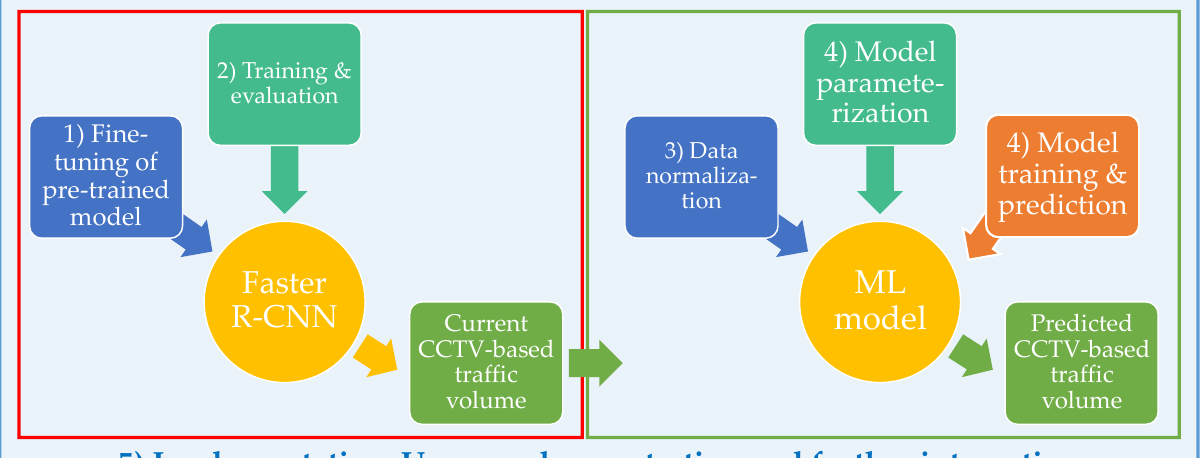
Figure 1. End-to-end CCTV-based traffic volume analysis and